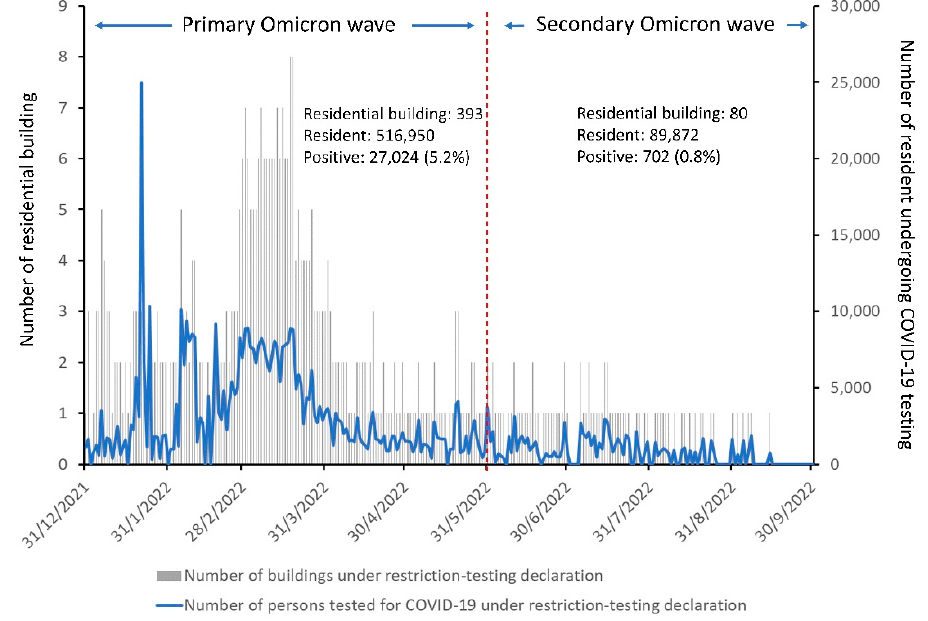
Figure 8. COVID-19 testing in the community under restriction-testing declaration for residents in residential buildings during the fifth wave (primary and secondary Omicron waves) of COVID-19 in Hong Kong.